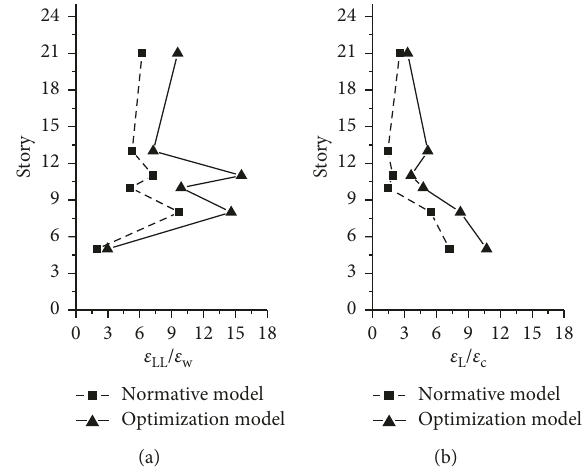
Figure 12: Strain ratio between vertical component and horizontal component. (a) Strain ratio of coupling beam and wall limb; (b) strain ratio of frame beam and frame column.